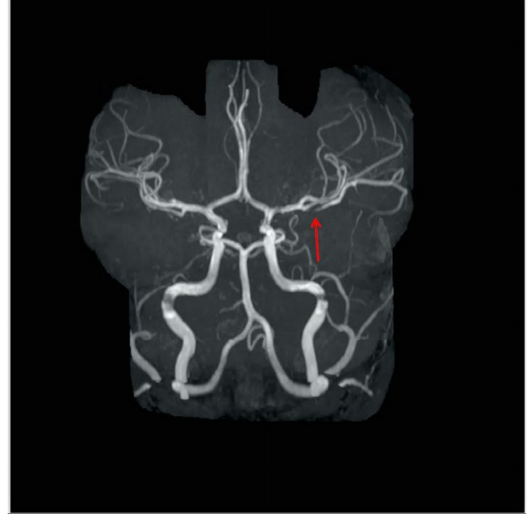
Figure 2. Magnetic resonance angiogram (MRA) shows a defect in the posterior branch of the left MCA four days after roller coaster